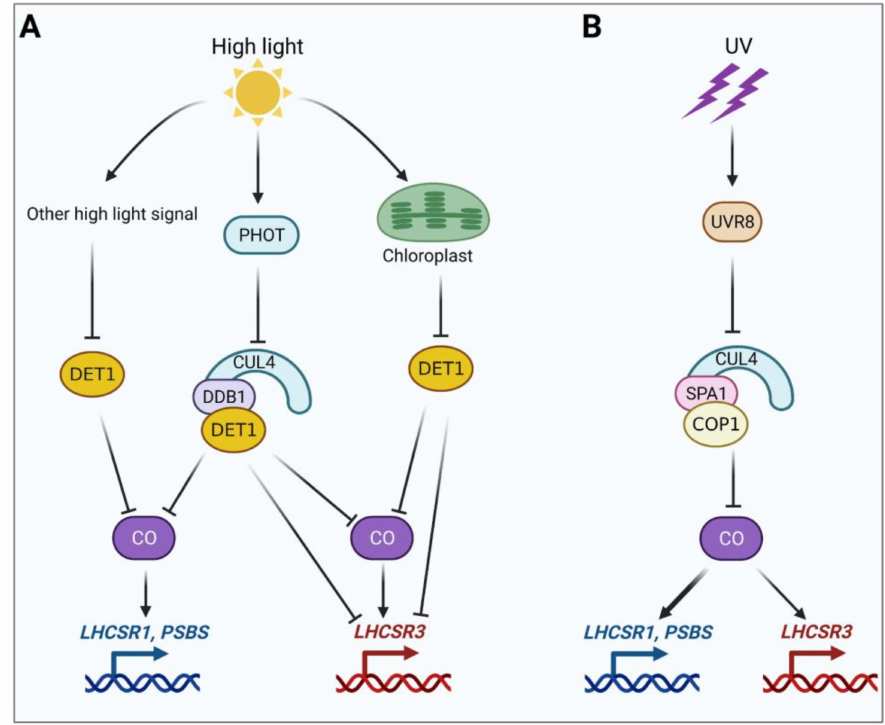
Figure 1. Models for the induction of LHCSR1 , LHCSR3 , and PSBS expression by high light and UV-B in C. reinhardtii . ( A ) Induction of LHCSR1 , LHCSR3 , and PSBS expression by high light via the putative E3 ligase complex CUL4-DDB1 DET1 and other DET1-dependent high-light signaling pathways. ( B ) Induction of LHCSR1 , LHCSR3 , and PSBS expression by UV-B via the SPA1/COP1- dependent E3 ligase complex. See the main text for a discussion of the related signaling